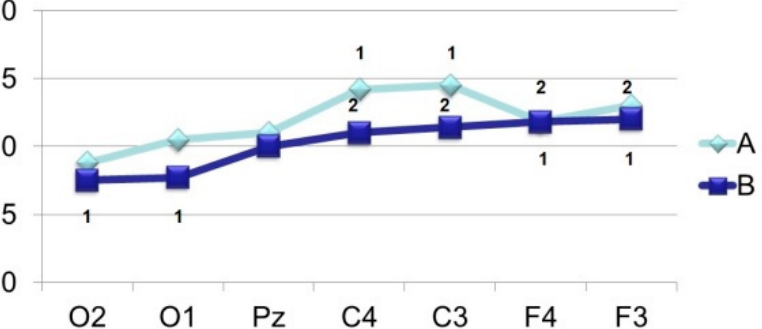
Figure 4. Averaged values of amplitudes and factor characteristics of amplitudes and PL of the N 150 ERP component. Note. Legend in Figure 3.